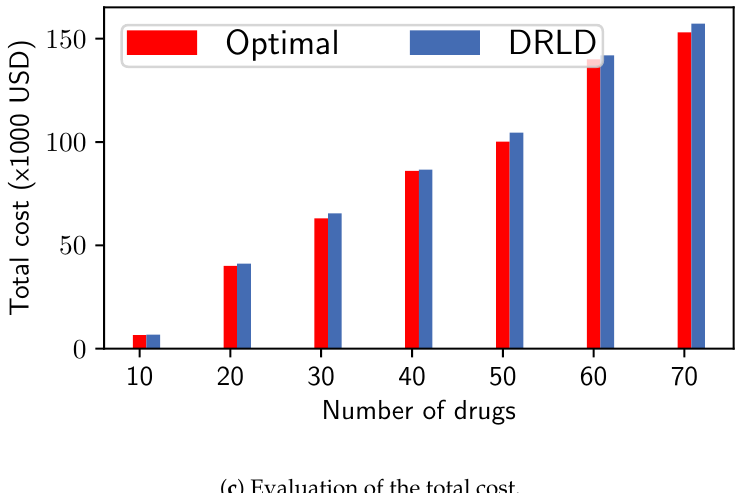
Figure 4. Convergence evaluation. DRLD, Deep Reinforcement Learning model for Drug